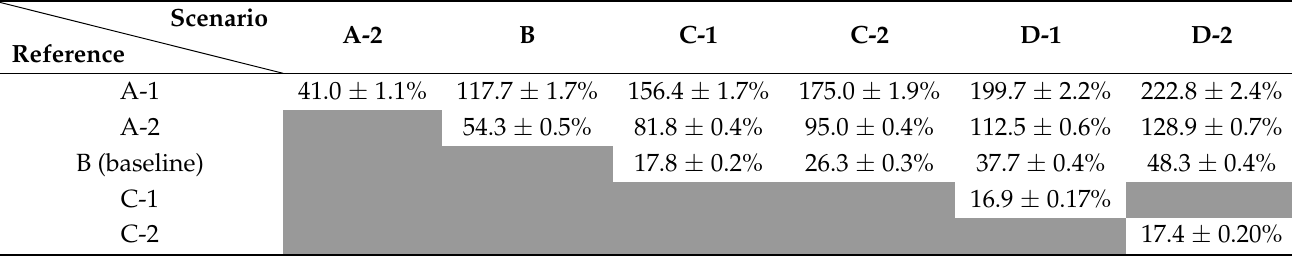
Table 3. Overhead of our trace collection solution for high-throughput read workloads in Cassandra. The overhead of our solution compared to the baseline is below 18% when using the snapshot mode in LTTng and below 27% when using the standard mode.